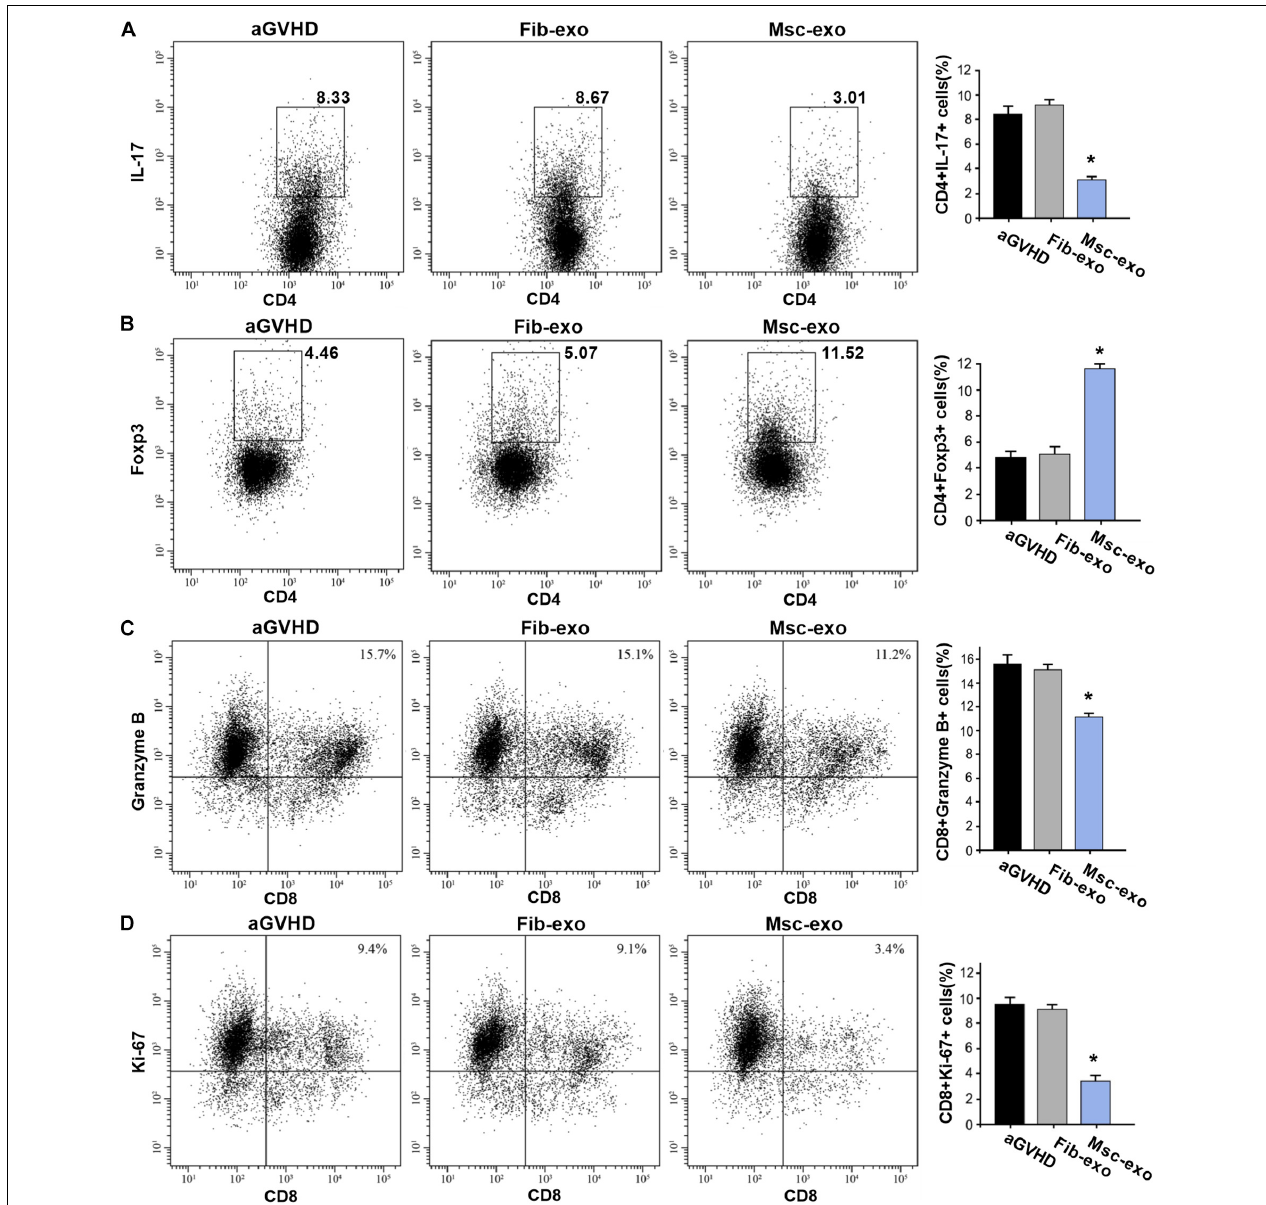
FIGURE 4 | Msc-exo could regulate the function and biology of T-cell subpopulation in acute graft-versus-host disease (aGVHD) mice. aGVHD mice were injected with either Fib-exo or Msc-exo, or untreated. 10 days after injection, Th17 (IL-17 + CD4 + ) and Treg (Foxp3 + CD4 + ) in the blood were analyzed by flow cytometry. The proliferation and cytotoxicity of T cells were analyzed with markers of granzyme B and Ki-67 using flow cytometry. (A) Representative plots (left) and the quantified data of IL-17 + CD4 + T cells in the exosome treated and untreated mice. (B) Foxp3 + CD4 + T cells in the treated and untreated mice. (C) The cytotoxicity of T cells was measured by the expression of Granzyme B through flow cytometry. (D) The proliferation of T cells in the exosome treated and untreated aGVHD mice. N = 3–4 in each group. Data were representative of at least two independent experiments. * p <